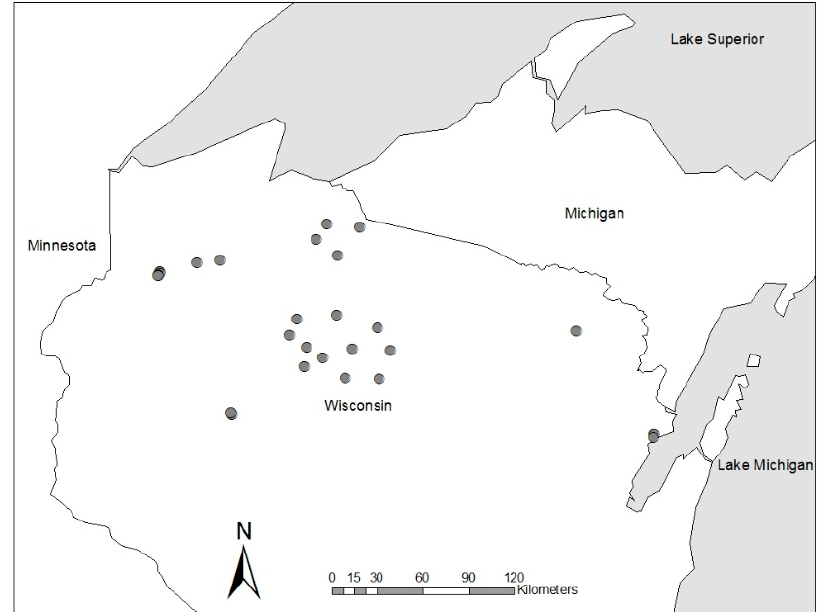
Figure 5. Location of Swamp Hardwood Silviculture Trials maintained by the Wisconsin Department of Natural Resources. Trials are concentrated in north-central Wisconsin, which contains the greatest concentration of black ash wetlands in the state.